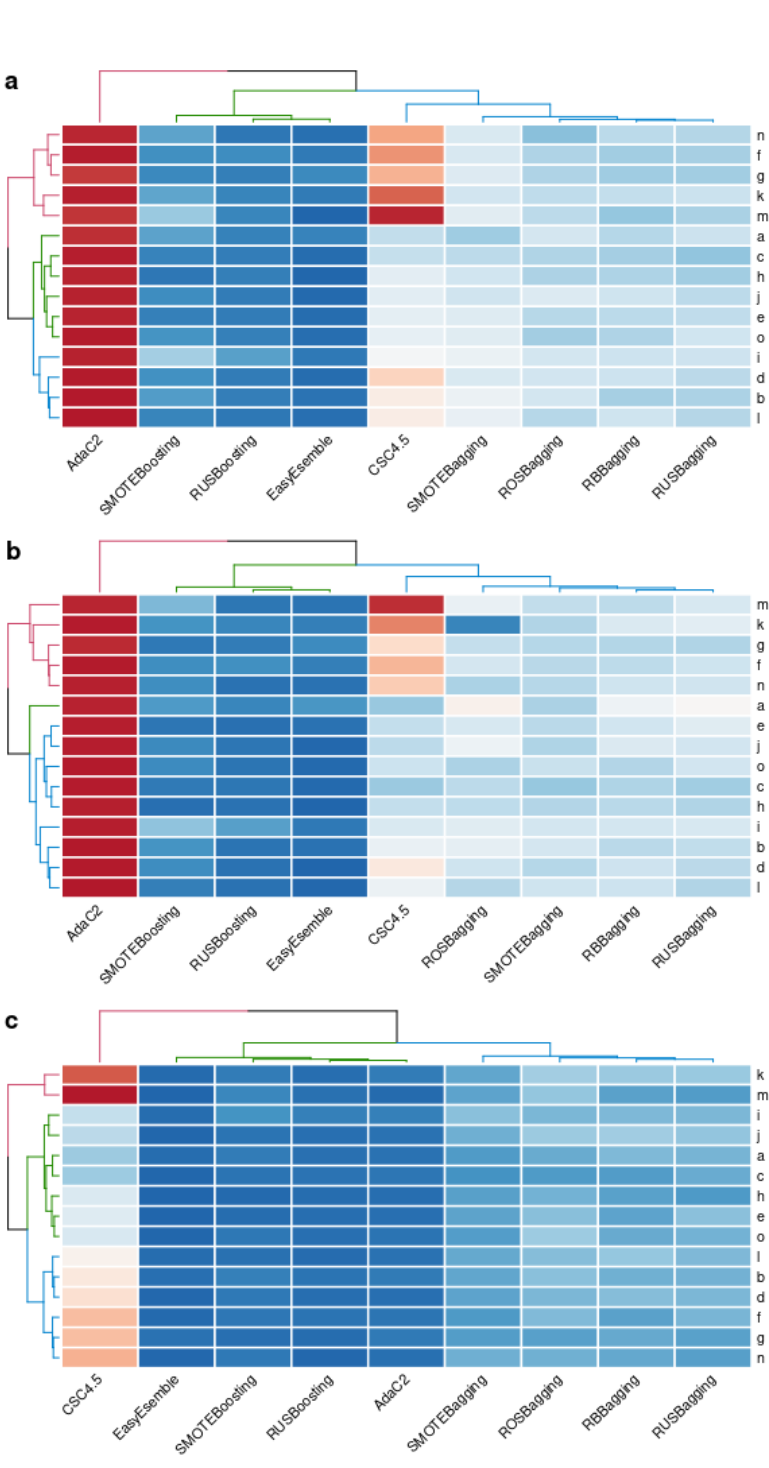
Figure 3. Hierarchical clusters of classifiers and datasets in terms of balanced accuracy ( a ), kappa ( b ), and AUC ( c ) metrics. The clusters are shown by three colors of dendrogram